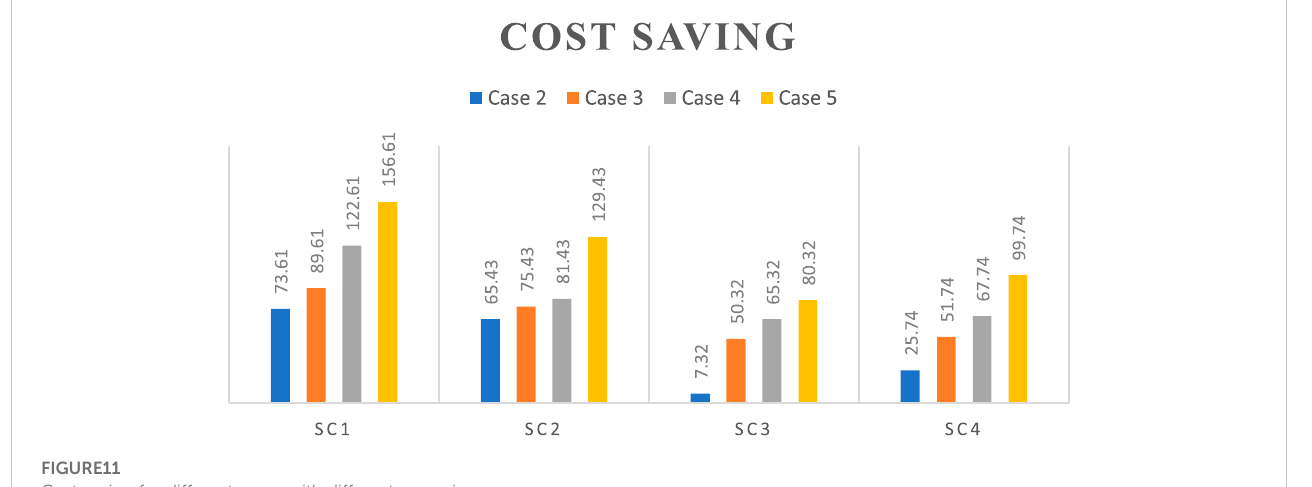
FIGURE11 Cost saving for different cases with different scenarios.